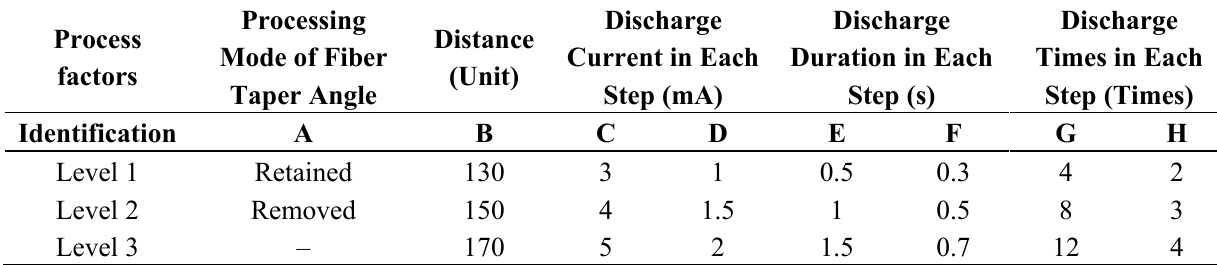
Table 1. Process factors and levels.